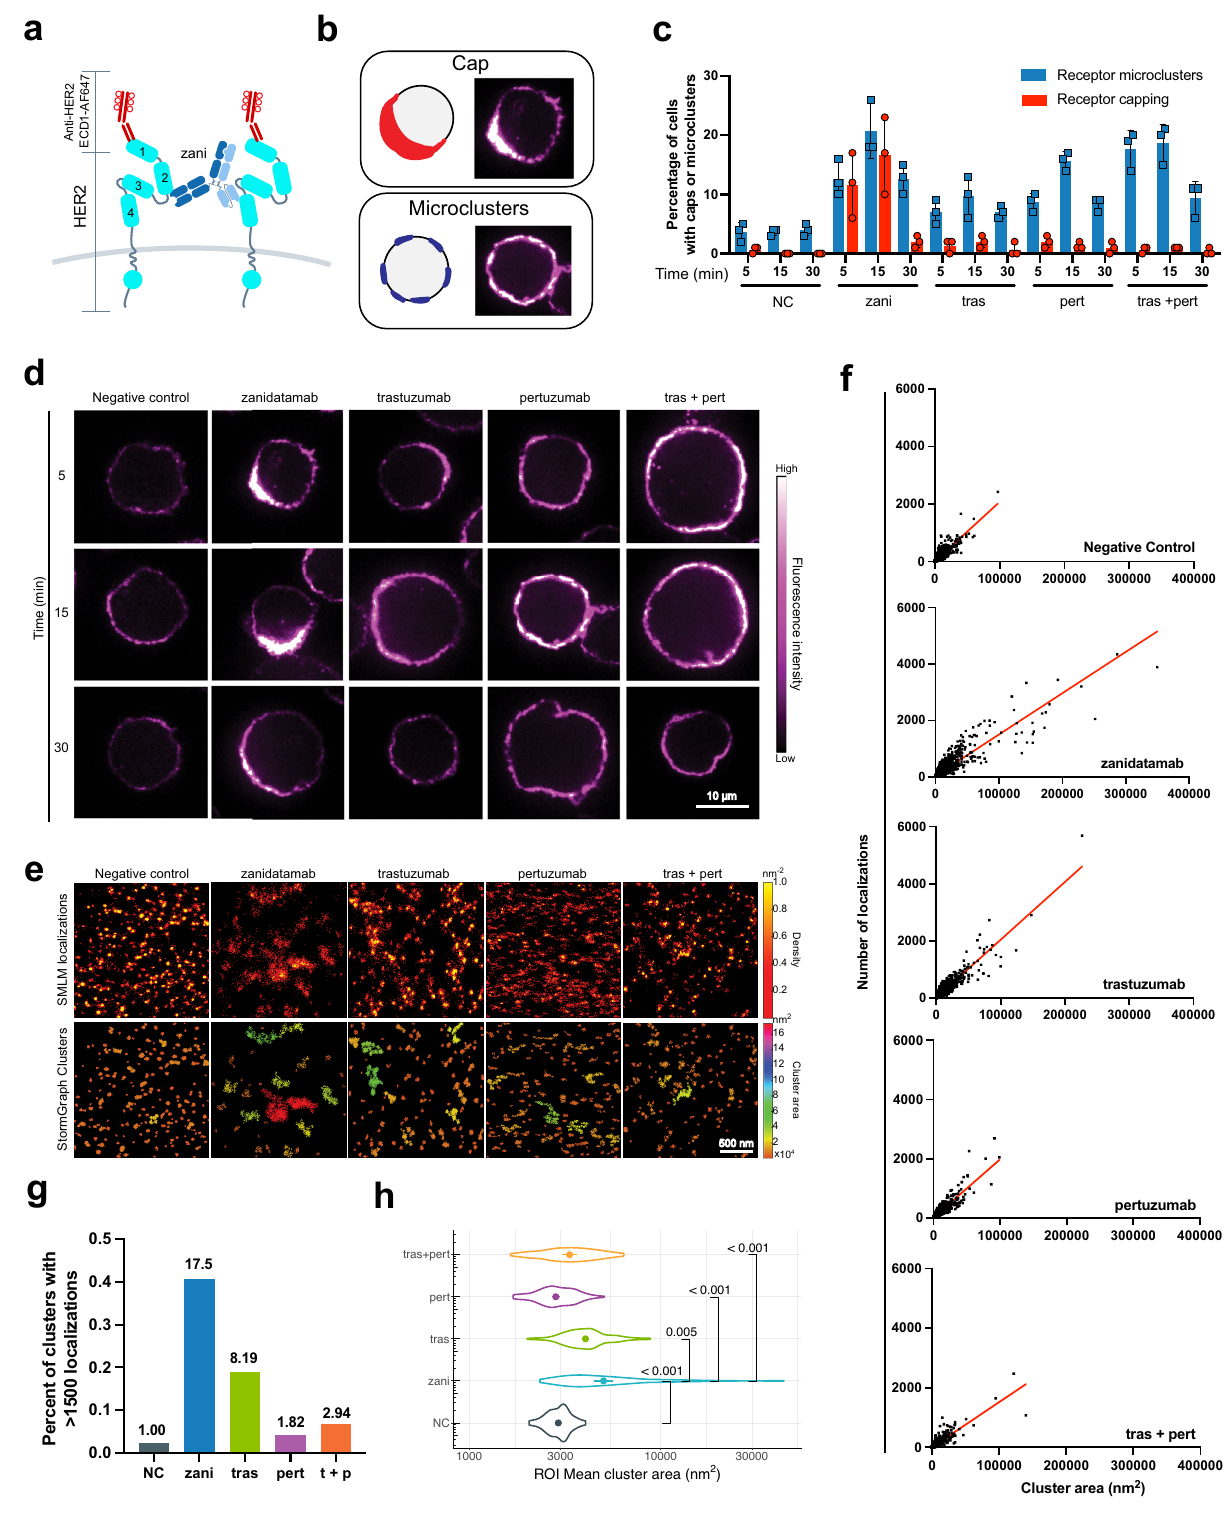
ForeachAbtreatment,weplottedthenumberoflocalizationsper cluster versus cluster area for each cluster (>2900 clusters per con- dition) (Fig. 3f). Note that there was a largely linear relationship between cluster area and the number oflocalizations per cluster for all Ab treatments ( R 2 =0.765 – 0.855) (Fig. 3f). For all Ab treatments, 97 – 99% of the HER2 clusters detected (>2900 clusters per condition) contained fewer than 500 localizations (Fig. 3f). Importantly,